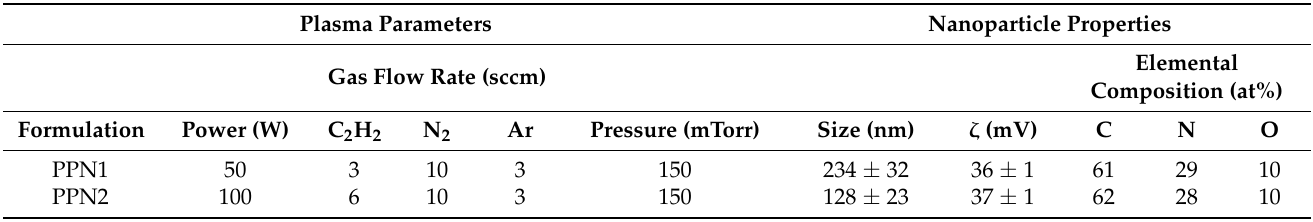
Figure 1. Schematic depicting the overall goal of this work. Two PPN formulations were synthesized in acetylene-containing dusty plasmas for evaluation of their cytotoxicity in various cell types and systemic biosafety in BALB/c mice. Scale bars represent 50 nm. Table 1. Plasma parameters (radiofrequency input power, gas flow rates, and pressure) that were adopted to synthesize the two PPN formulations studied in this work. The main physical properties (size and zeta potential measured in ultrapure water) and the relative elemental carbon, nitrogen, and oxygen compositions are also shown.